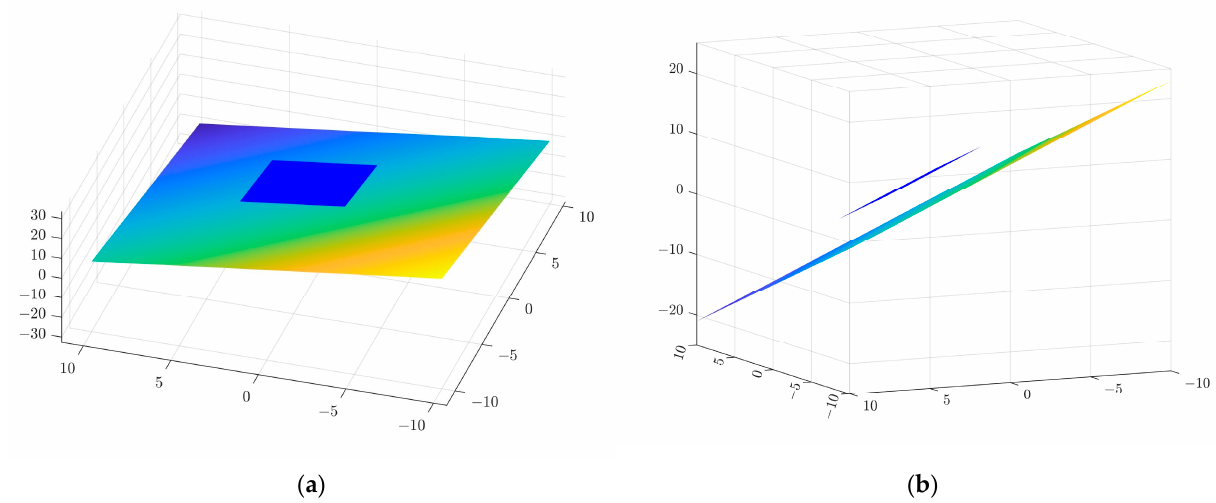
Figure 19. Fitting spatial plane images. ( a ) Top view. ( b ) Side view. Table 1. Measurement results of the standard gauge blocks (mm).